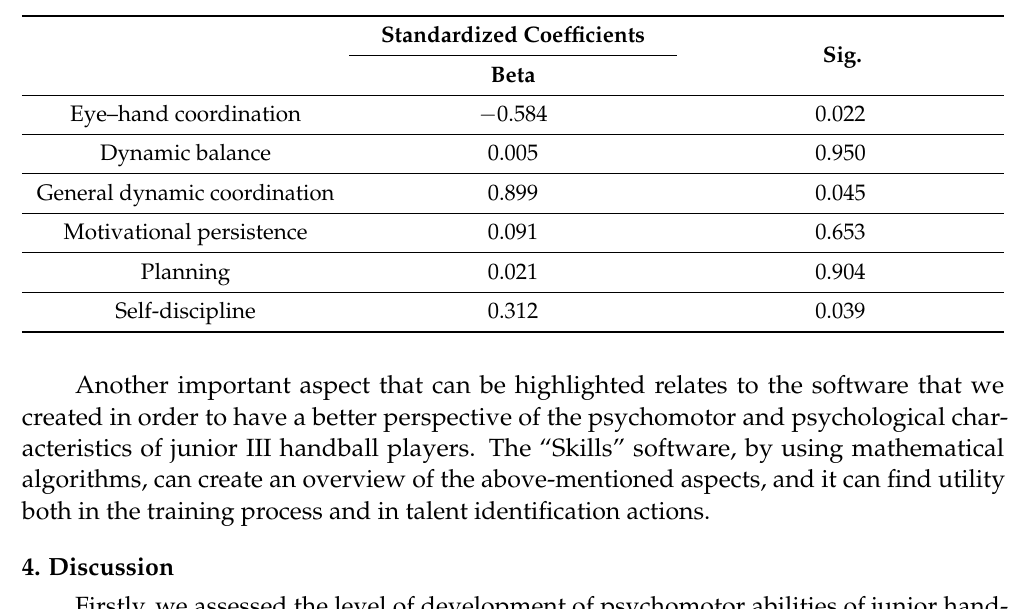
Table 7. Statistical significance of variables in the general